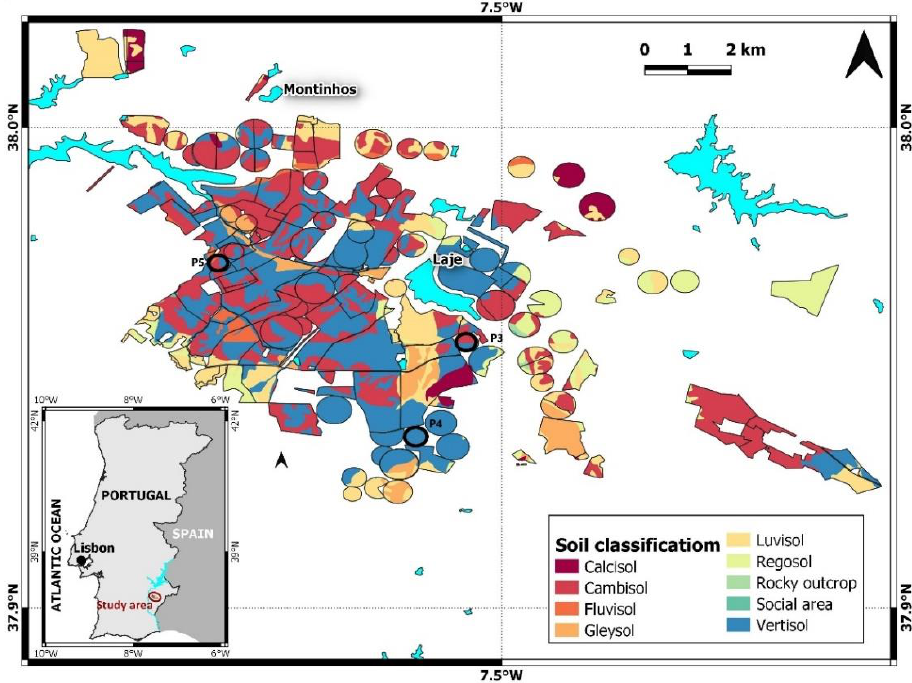
Figure 1. Hydro-agricultural area (HAA) of Brinches-Enxoé, prevalent reference soil groups, and location of the farm plots under study (P3, P4, and P5, marked with bold black circles). The bottom-left inset shows the location of the HAA in southern Portugal (adapted from [23]).